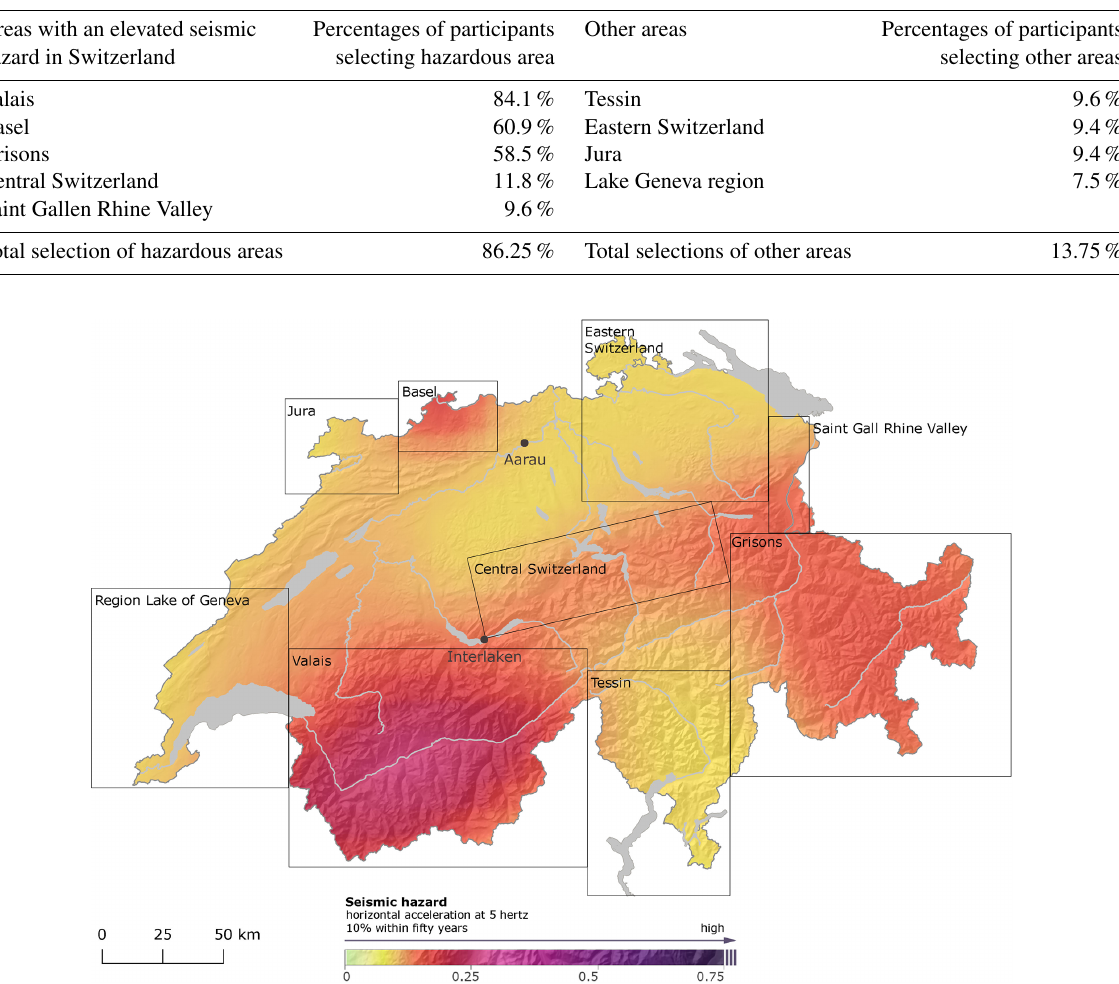
Table 5. Participants’ selection of hazardous and other areas in Switzerland ( N = 491) with the map displayed. Number of selections taken is 1280.